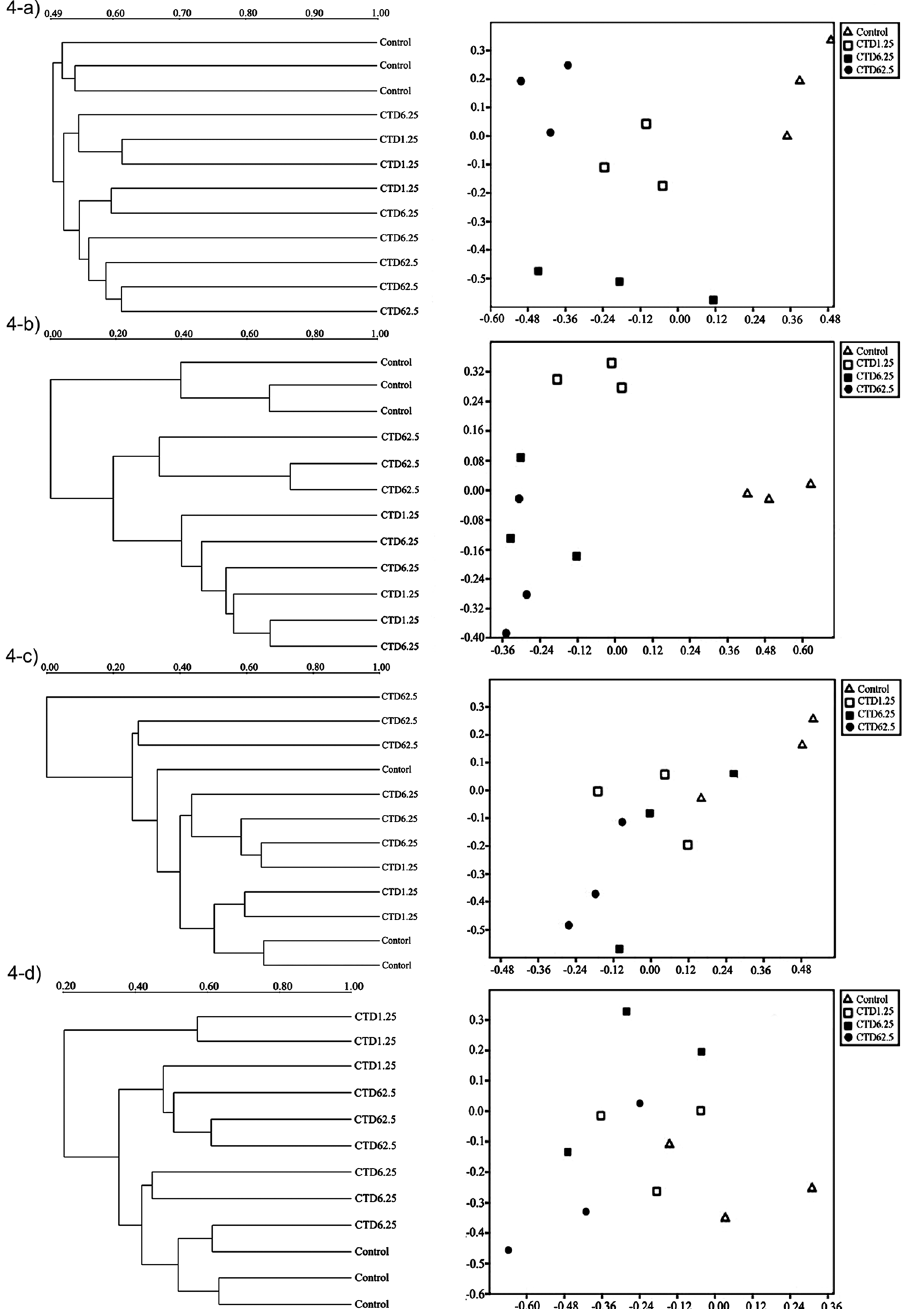
Figure 4. UPGMA and nMDS analyses of 18S rRNA gene from soil fungus. ( a – d ) Samples treated with cantharidin (1.25, 6.25 and 62.5 mg kg − 1 DW soil) and control at different incubation times ( a , 3 days; b , 7 days; c , 15 days and d , 35